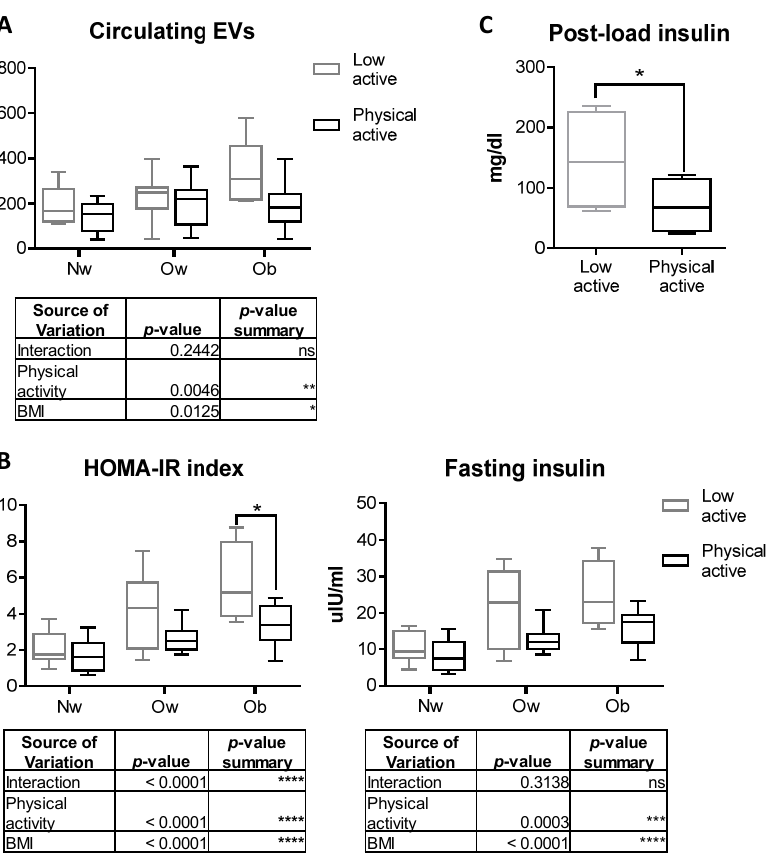
Figure 6. ( A ) Quantification of circulating EVs by FACS in participants with normal-weight, overweight and obesity in relation to sport activities. The table below shows the results from ANOVA 2-way analysis. ( B ) Evaluation of basal HOMA-IR Index and fasting plasma insulin in participants with normal weight, overweight and obesity performing sport activities (physically active) in comparison to their counterparts with a sedentary lifestyle (low active). ( C ) Evaluation of plasma insulin following glucose load assessed in children with obesity performing sport activities (physically active) in comparison to their counterparts with a sedentary lifestyle (low active). Normal weight group: n = 7 low active and n = 18 physically active; overweight group: n = 9 low active and n = 15 physically active; obese group: n = 5 low active and n = 15 physically active. * p < 0.05.